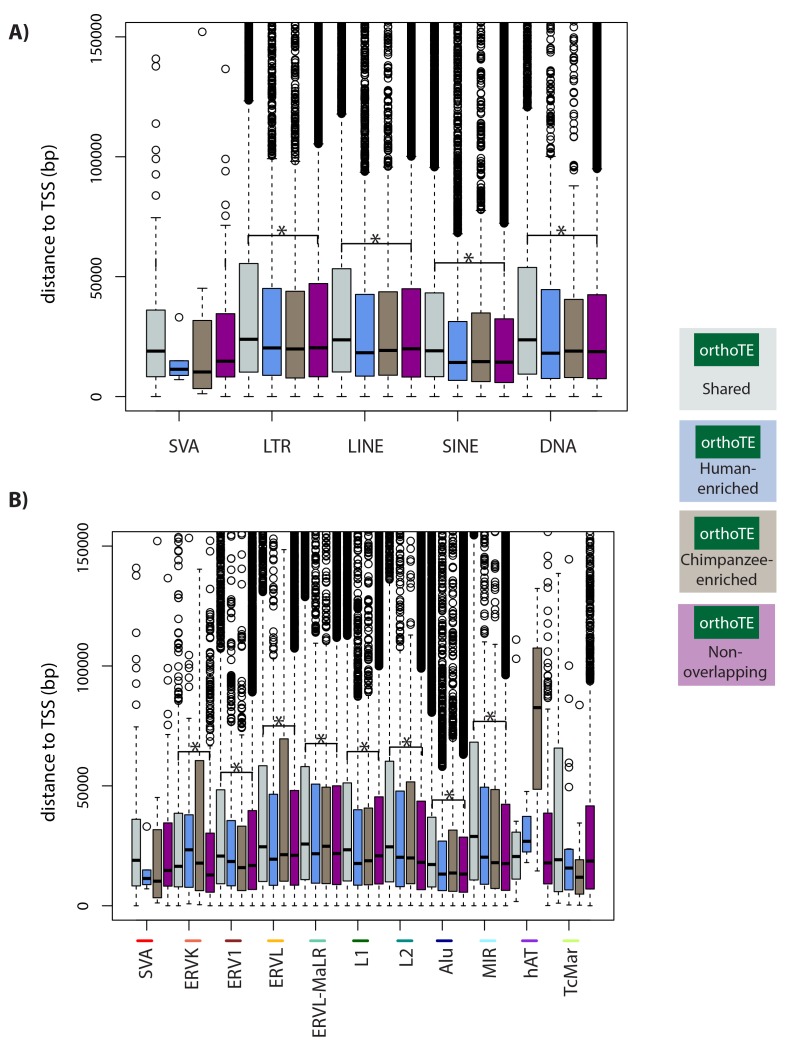
TEs, within a class, that are similarly enriched for H3K9me3 in both species tend to be further away from the nearest TSS than TEs that do not overlap H3K9me3 .(A) The absolute distance between each TE in each of the TE classes and the nearest TSS. (B) The absolute distance between each TE in each of the TE families and the nearest TSS. Families are ordered by the proportion of TE instances that overlap H3K9me3 regions (highest-to-lowest from left-to-right). Asterisk denotes a significant difference between the Shared and Non-overlapping categories (Wilcoxon-rank sum test; *p<0.001).